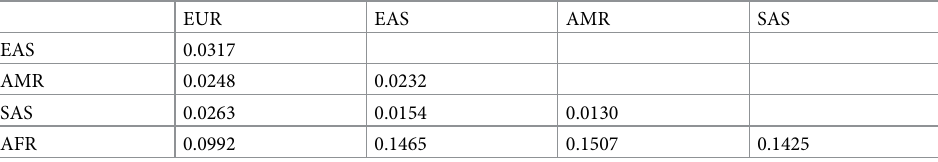
Table 1. Pairwise F ST values between populations.